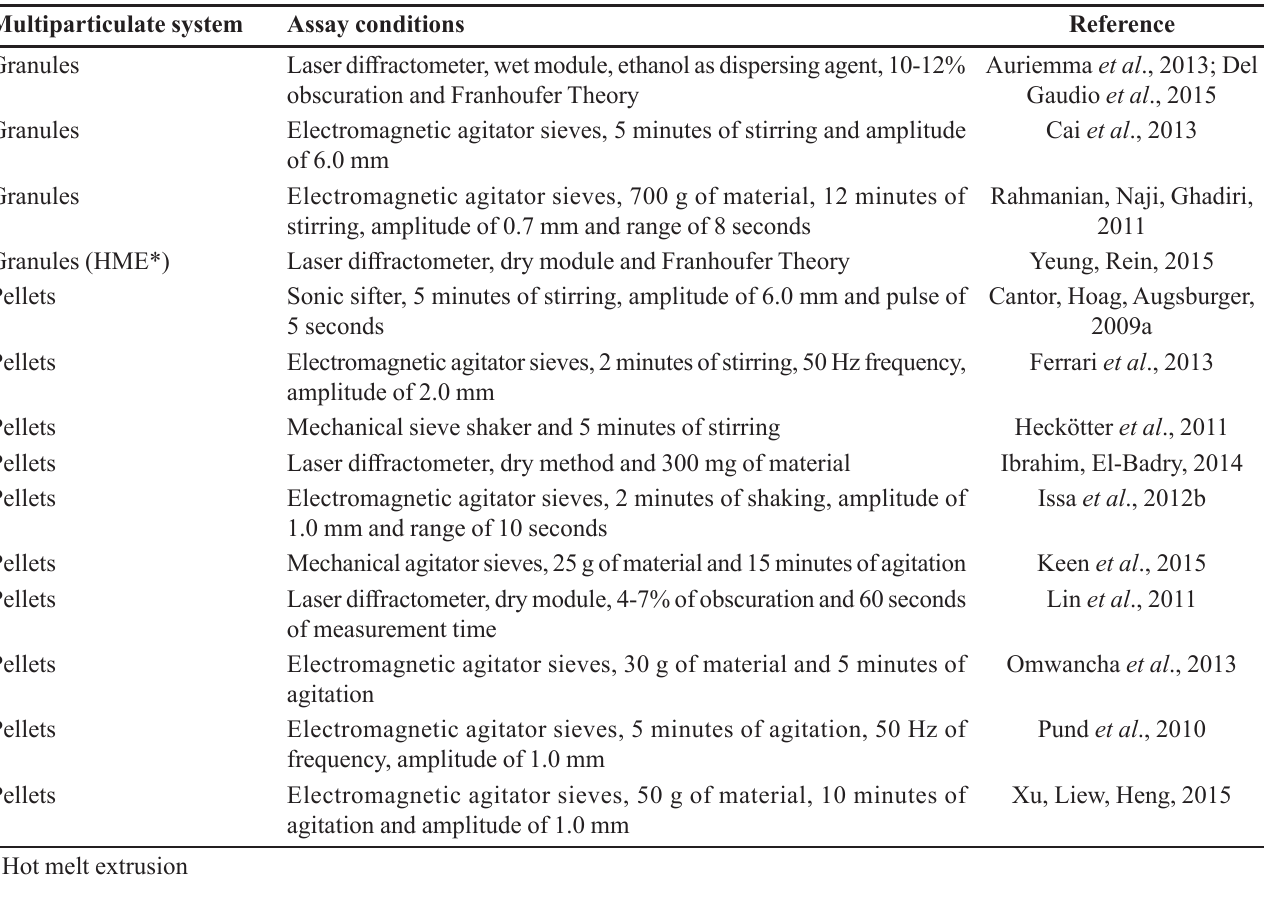
TABLE I - Example descriptions of parameters used for particle size distribution in multiparticulate systems Multiparticulate system